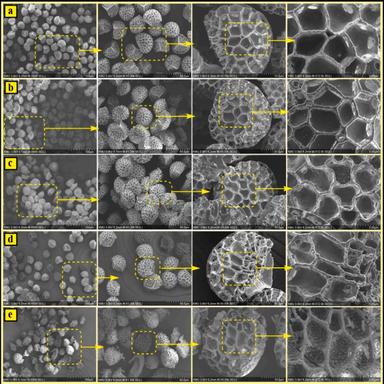
SEM images of (a) the Sp, (b) the act. Sp, (c) Sp-T, (d) Sp-TA and (e) the fluorescent Sp-TAB hybrid material.